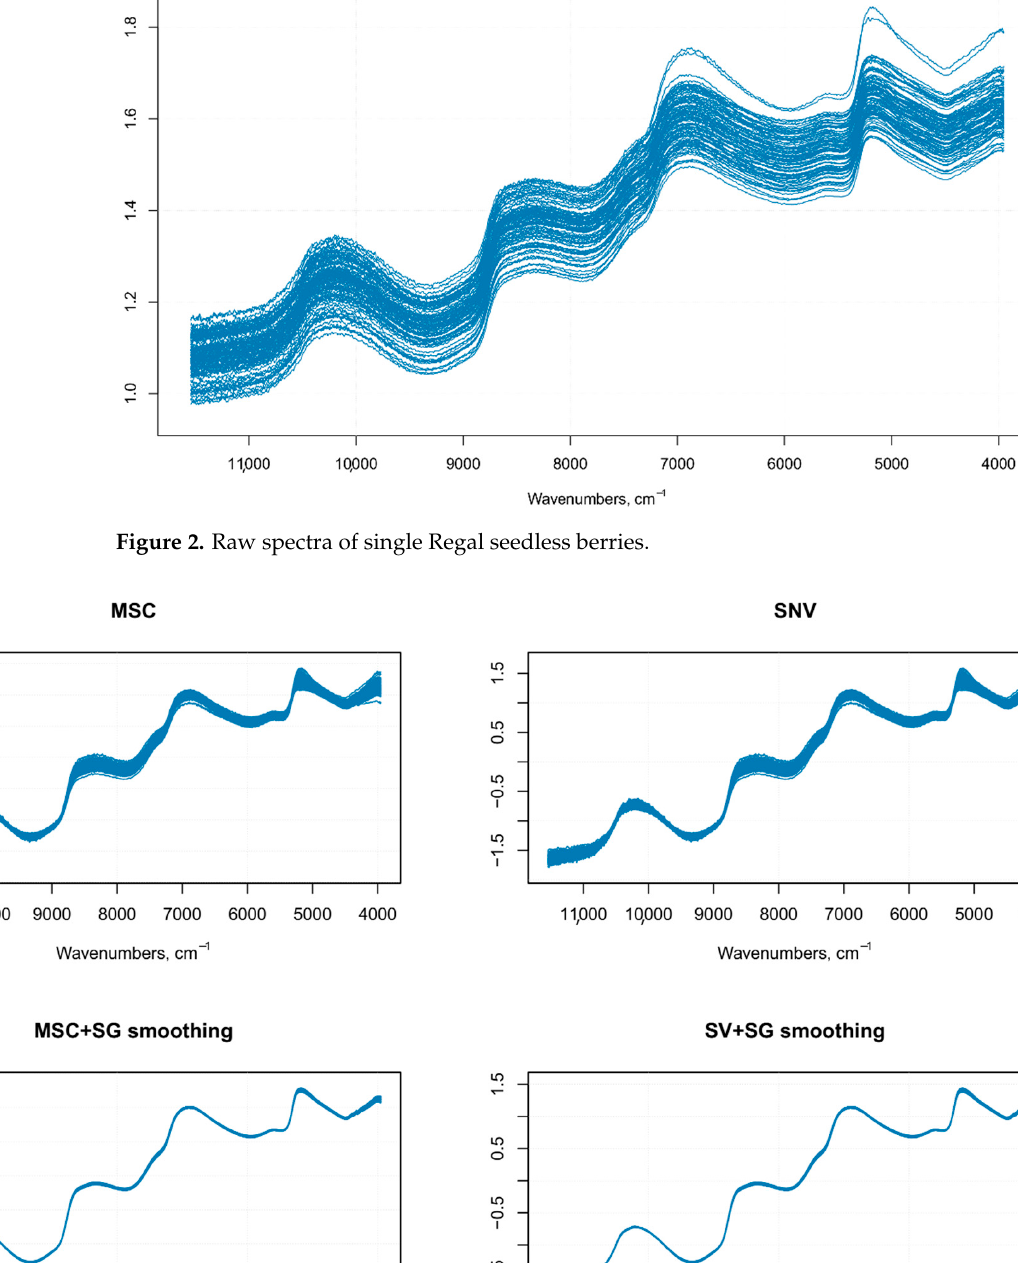
Figure 4. SGD1 and SGD2 with different polynomial order (p) and frame size (m).